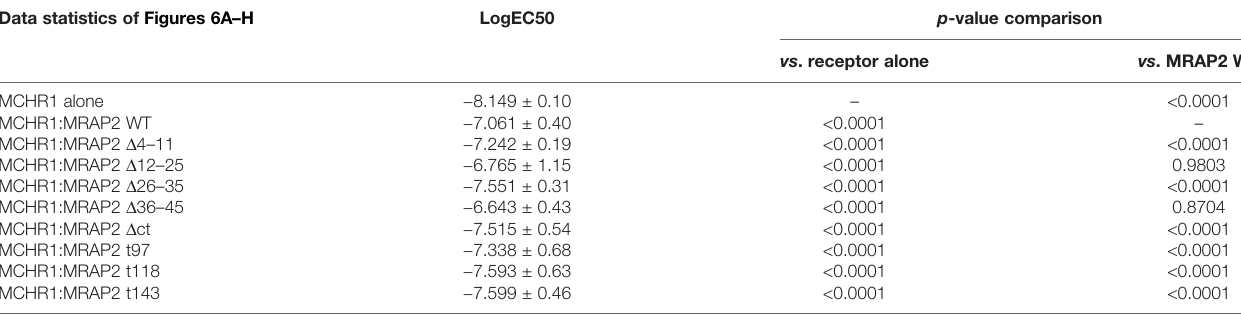
TABLE 1 | Statistical analysis of MCHR1 in the presence of different MRAP2 mutants in response to MCH. Data statistics of Figures 6A – H